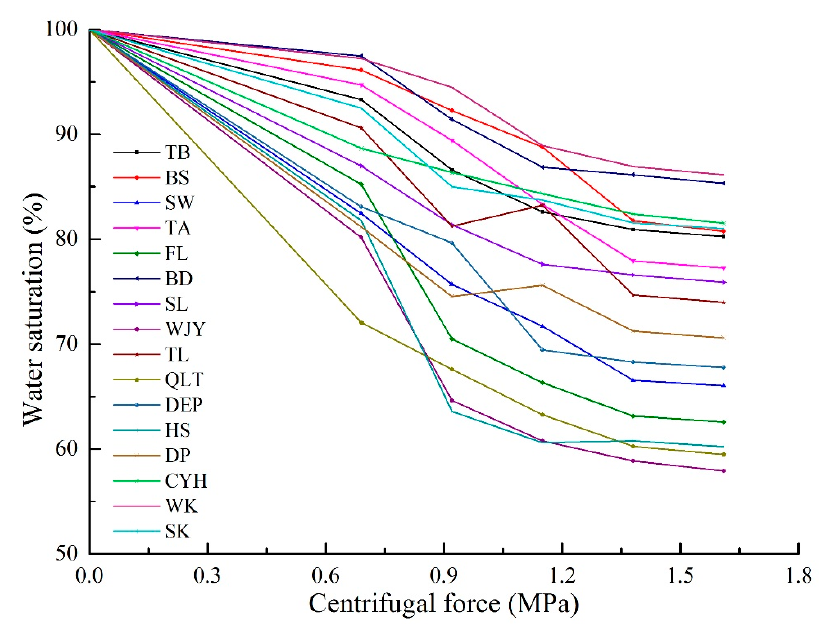
Figure 4. Variation diagram of water saturation after centrifugation of different coal samples.